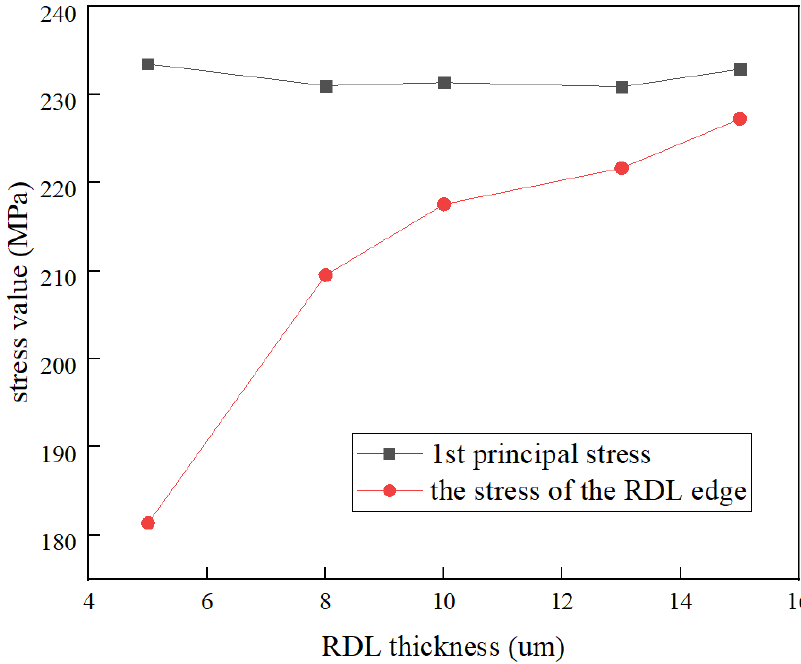
Figure 7. Effect of RDL thickness on the wafer on stress evolution.